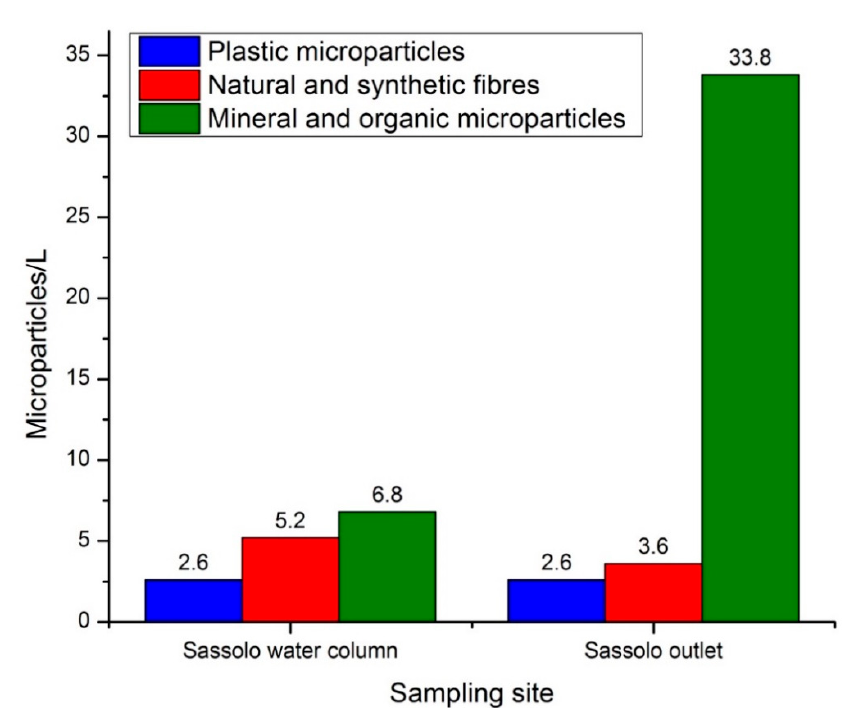
Figure 3. Distribution and microparticle concentrations (microparticles / L) found in the sample of the main hole water column (H) and at the outlet of the lake (O).